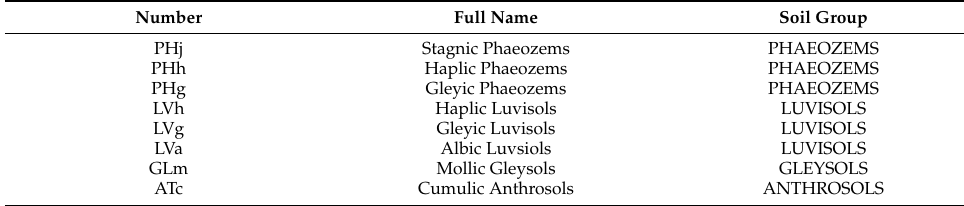
Table 2. Soil type table.